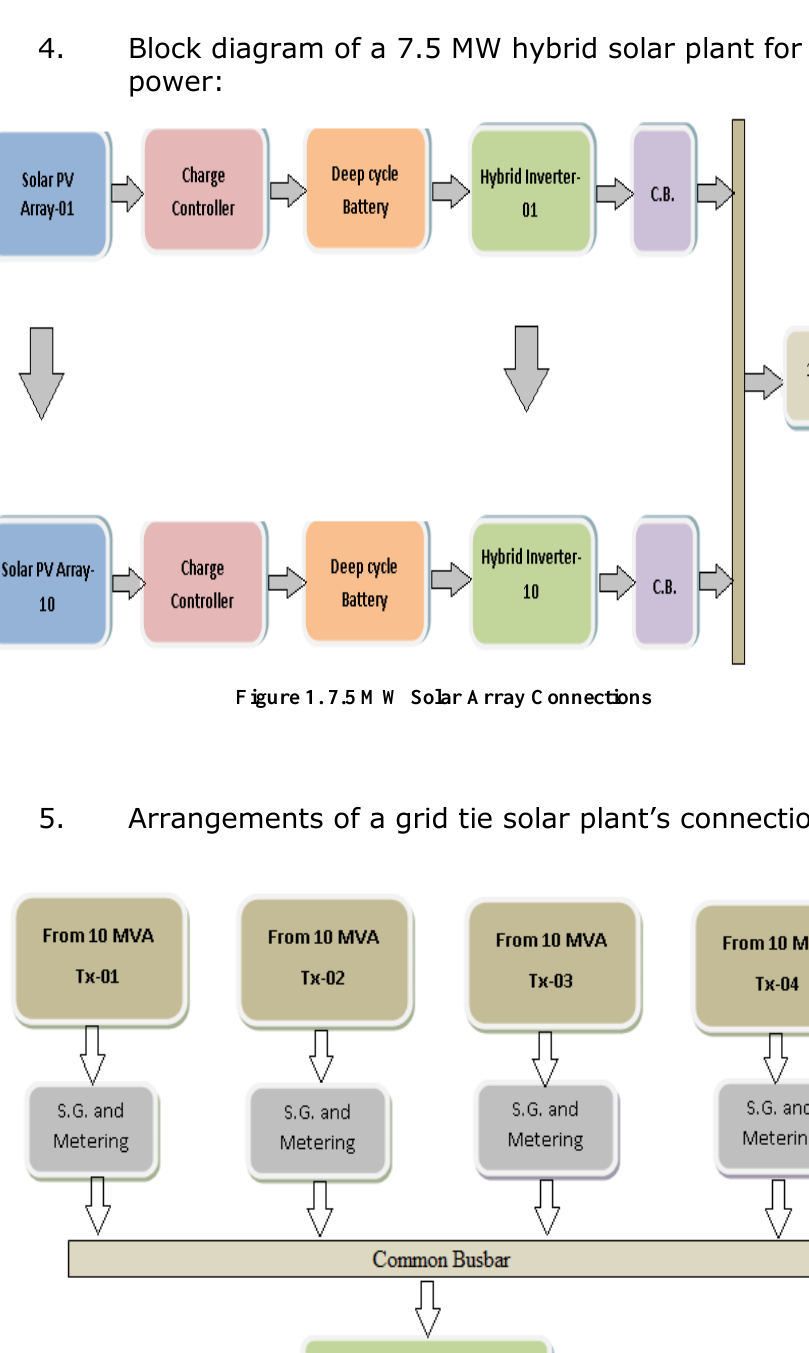
Figure 2. Grid Tie Connection Diagram of 7.5 MW x 4 Solar